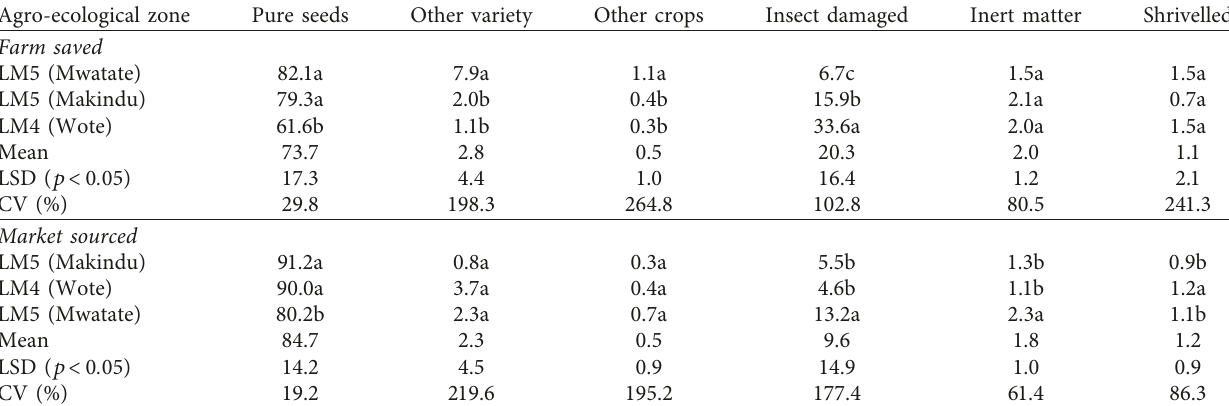
Table 4: Percentage of physical purity components of cowpea seeds obtained from Wote, Makindu and Mwatate in various agroecological